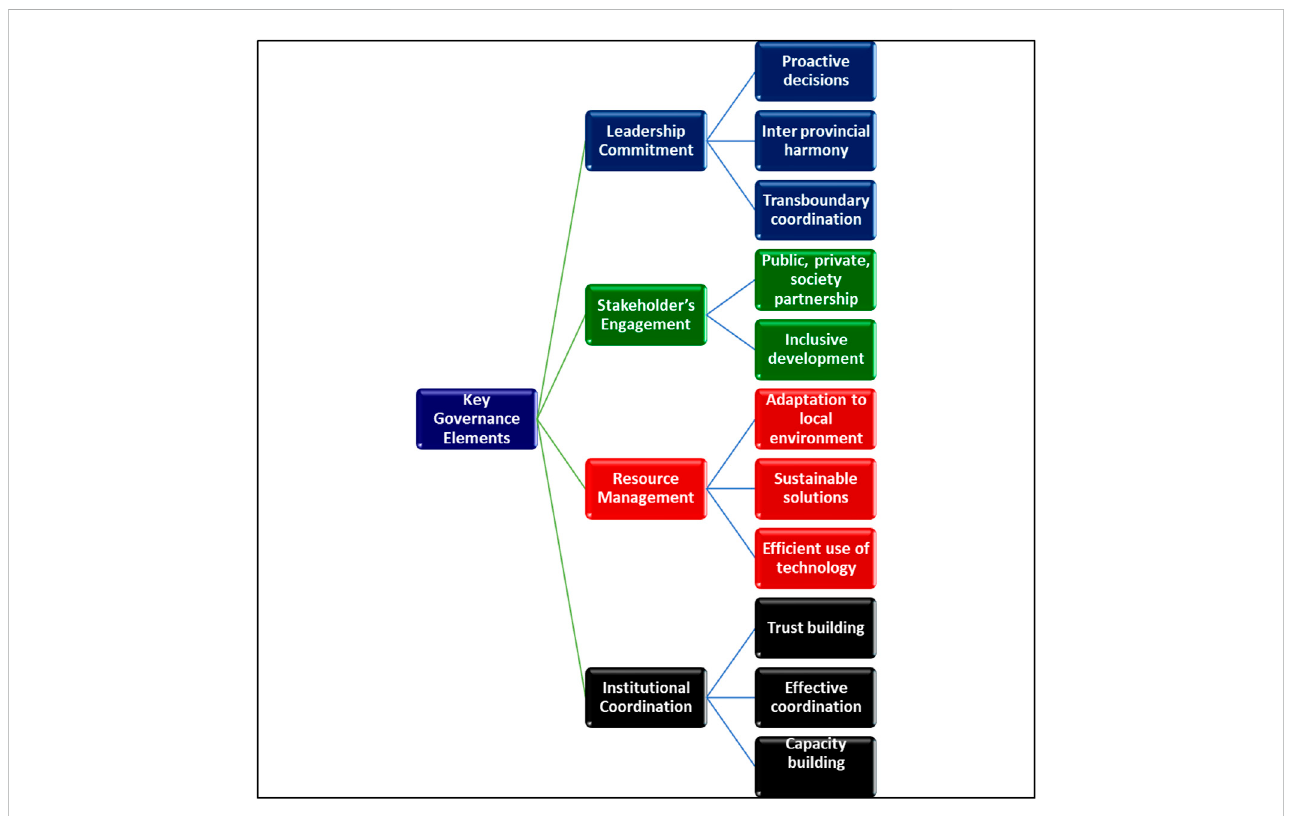
FIGURE 13 Suggested terms of reference for water governance